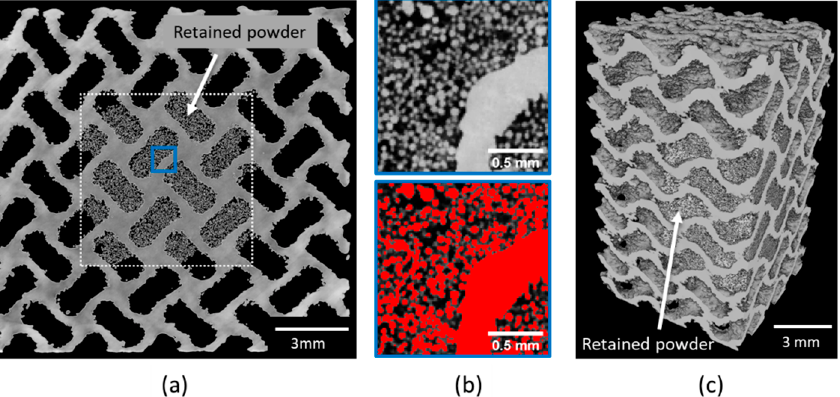
Figure 3. ( a ) Reconstructed XCT slice of the 2 × 04 specimen subjected to PRS showing the RP particles; ( b ) Magnified region indicated by blue rectangle in ( a ) and the result of the automatic thresholding using a standard Otsu’s method; ( c ) 3D rendering of the reconstructed TPMSS with the RP inside.